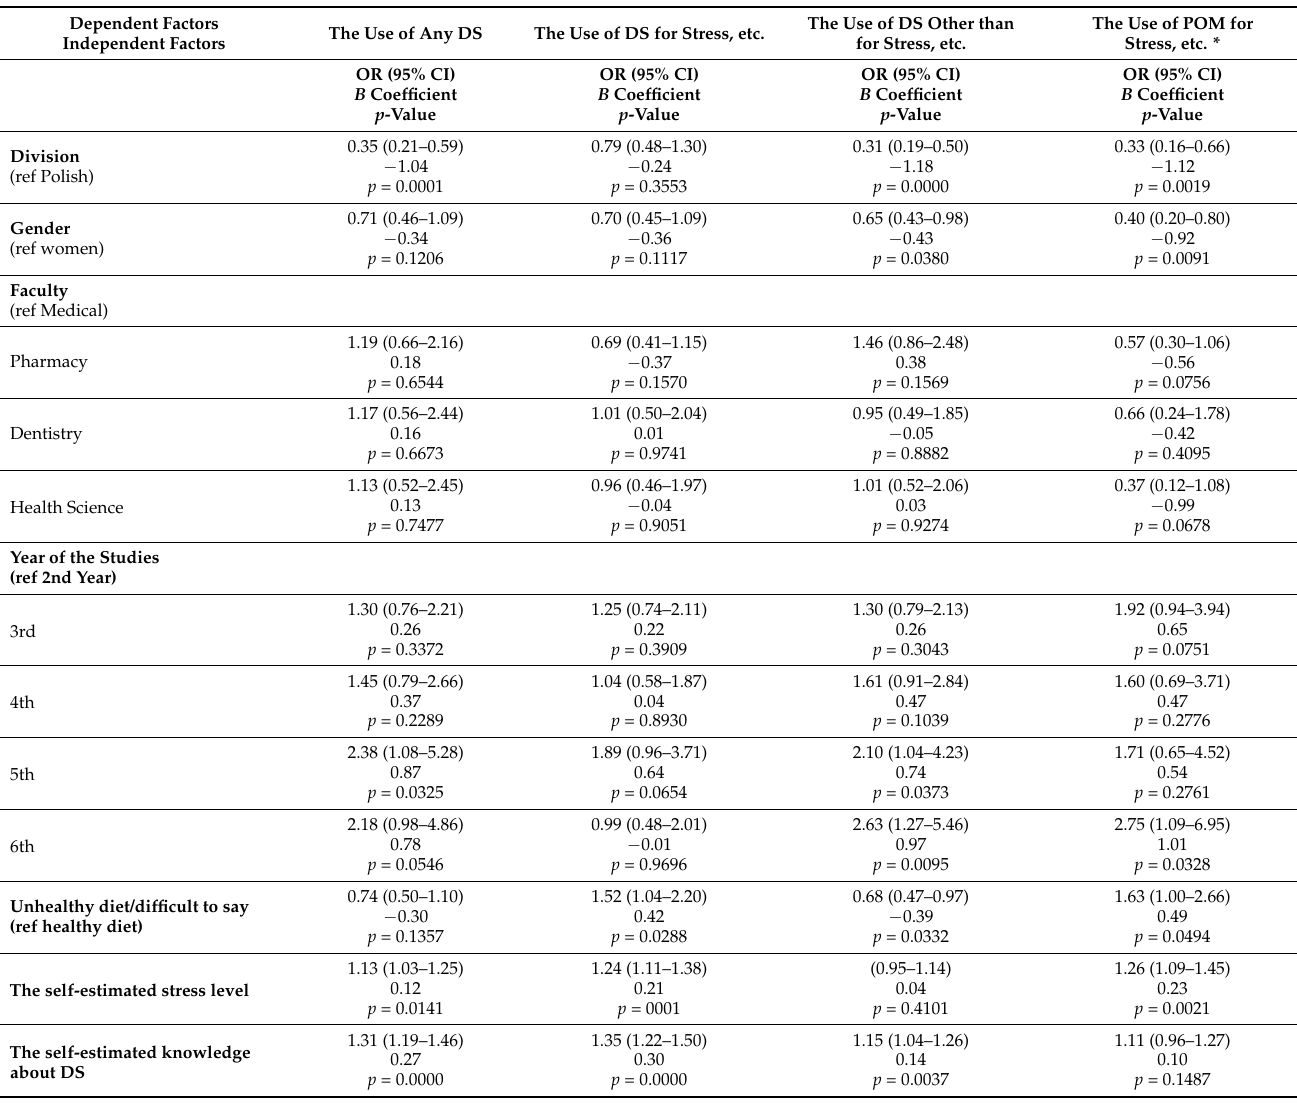
Table 5. Correlation between different factors and the use of DS and POM. Analyses were performed using the logistic regression (OD—odds ratio, CI—confidence interval). * From other factors influenc- ing the use of POM, checked in chi-square test but not included in the Table 5, significant impact of the use of DS for stress, anxiety, depression, or sleeping problems ( p = 0.0001, OD: 0.27, CI: − 0.16–0.52) was